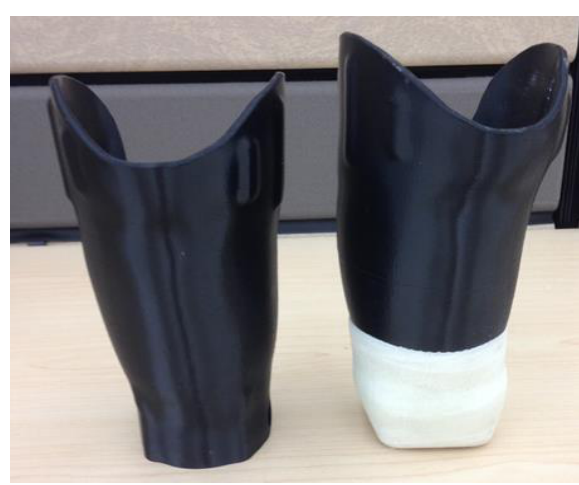
FIGURE 1: The two types of total surface bearing sockets used; the left one was made for use with locking liners with a 4-hole pattern lock distally and the right one was designed for use with cushion liners and was attached to a distal attachment block and reinforced with fiberglass wrap.